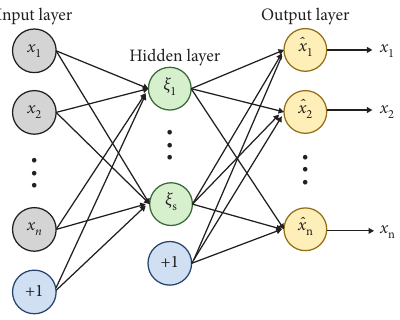
Figure 1: The structure of